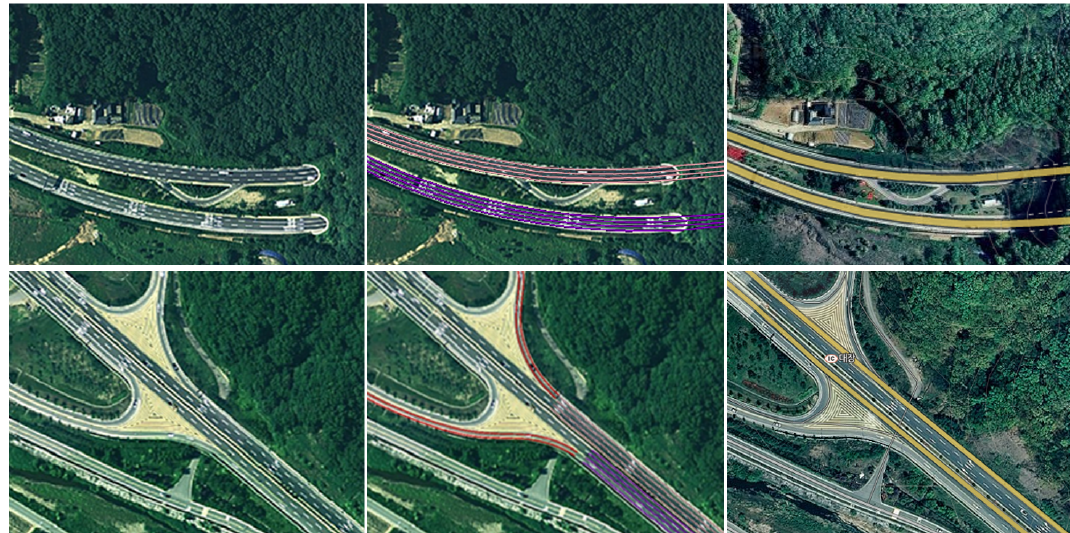
Figure 5. Detected road lanes on Route 1 are accumulated to build a lane-level digital map with the help of a GPS/INS sensor. The left column shows the satellite images, the middle column the resulting lane-level map overlapped with the satellite images and the right column the existing road-level map provided by Naver Map [41].